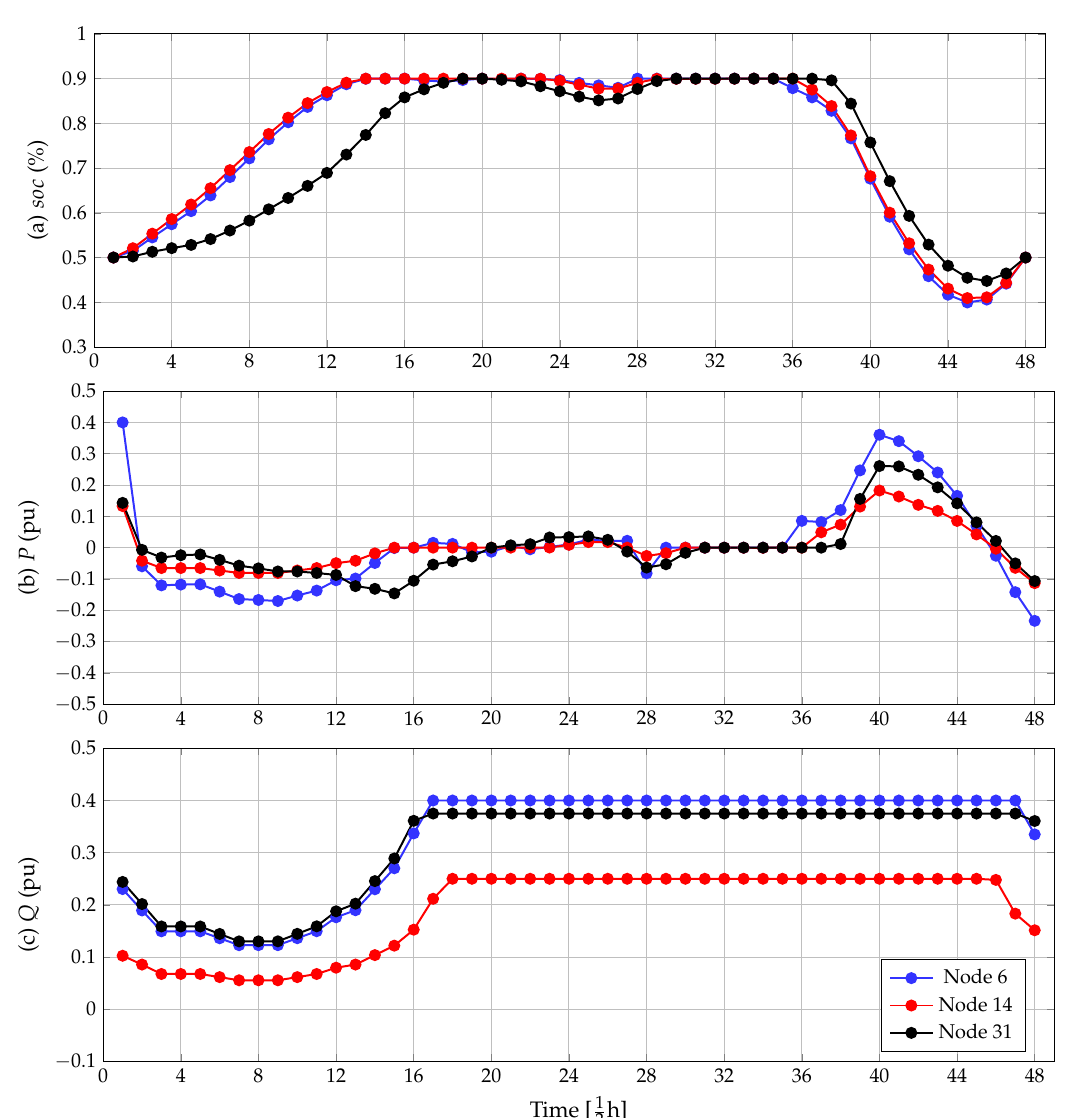
Figure 4. Behavior of BESS variables in solution no. 7 of Table 4: ( a ) states of charge, ( b ) active power, and ( c ) reactive